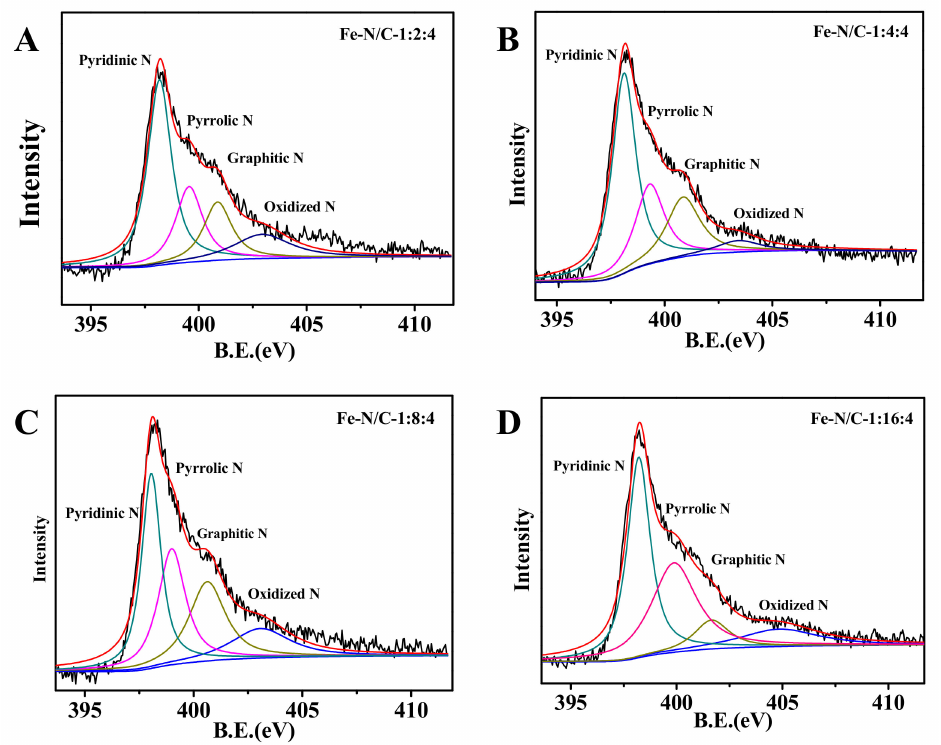
Figure 6. Deconvolution of N1s XPS spectra of: ( A ) Fe-N/C-1:2:4; ( B ) Fe-N/C-1:4:4; ( C ) Fe-N/C-1:8:4; and ( D ) Fe-N/C-1:16:4.